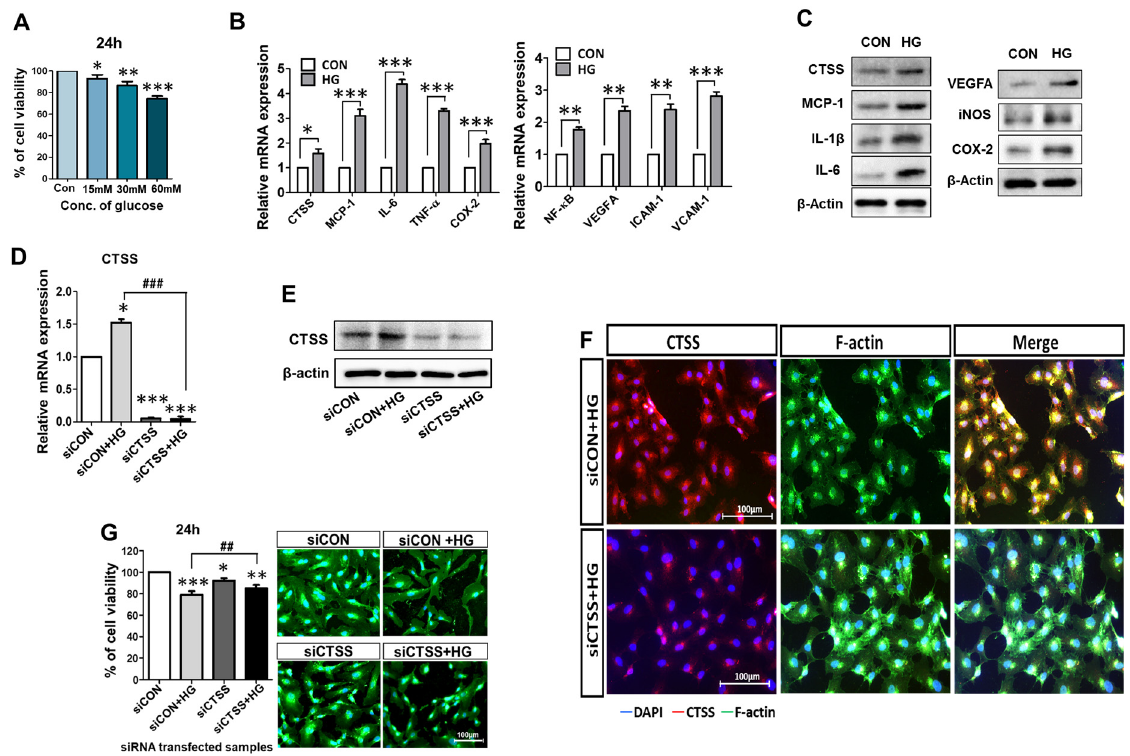
Figure 1. Upregulation of pro-inflammatory signals by glucose treatment (30 mM) and evaluation of CTSS knockdown in HUVECs. ( A ) HUVECs viability was assessed after treatment with different concentrations of glucose (15, 30, and 60 mM) for 24 h. ( B , C ) High expression levels of mRNA and protein of CTSS, pro-inflammatory factors, and vascular endothelial markers in samples treated with high glucose (HG) compared to control samples. ( D , E ) mRNA expression and Western blot analysis of CTSS expression after siRNA transfection. ( F ) Immunofluorescence analysis of CTSS expression. ( G ) HUVEC viability after siRNA transfection under hyperglycemic conditions was assessed by MTT assay and fluorescence staining. Values are expressed as mean ± SEM ( n = 3 biological replicates per group). p < 0.05 indicates statistical significance. * p < 0.05, ** p < 0.01, *** p < 0.001 versus control samples; ## p < 0.01, ### p < 0.001 versus HG-treated